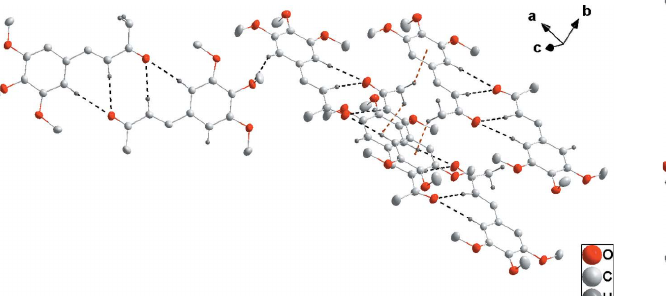
Figure 2 Detail of the C—H (cid:2)(cid:2)(cid:2) O hydrogen bonds (black dashed lines) and C— H (cid:2)(cid:2)(cid:2) (cid:2) (ring) interactions (orange dashed lines).